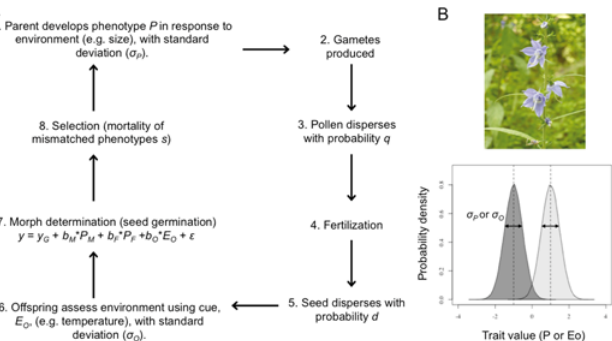
Figure 2. Plant model overview. A. Life history of plant model as explained in detail for each step, with; B. Upper: picture of C. americanum , the perennial herb species which provides the biological motivation for this model; lower: a schematic explaining the role of the variable parameters σ P and σ O in determining the environment-specificity of the parental phenotype or offspring cue, both assumed to be Gaussian traits with standardized means of-1 and 1 in the shade and light environments respectively. Image: L.